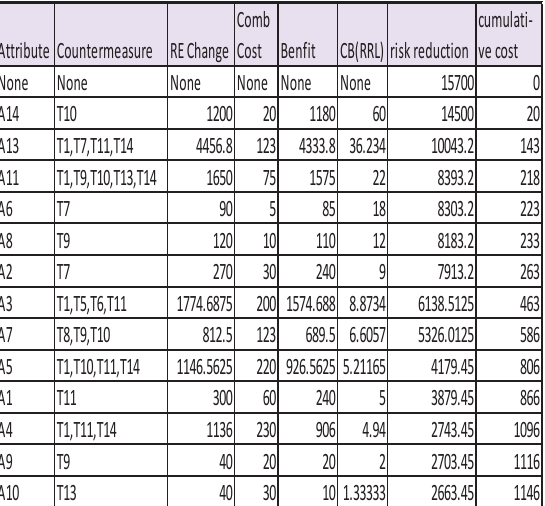
Table 7: Experiment#2 Output